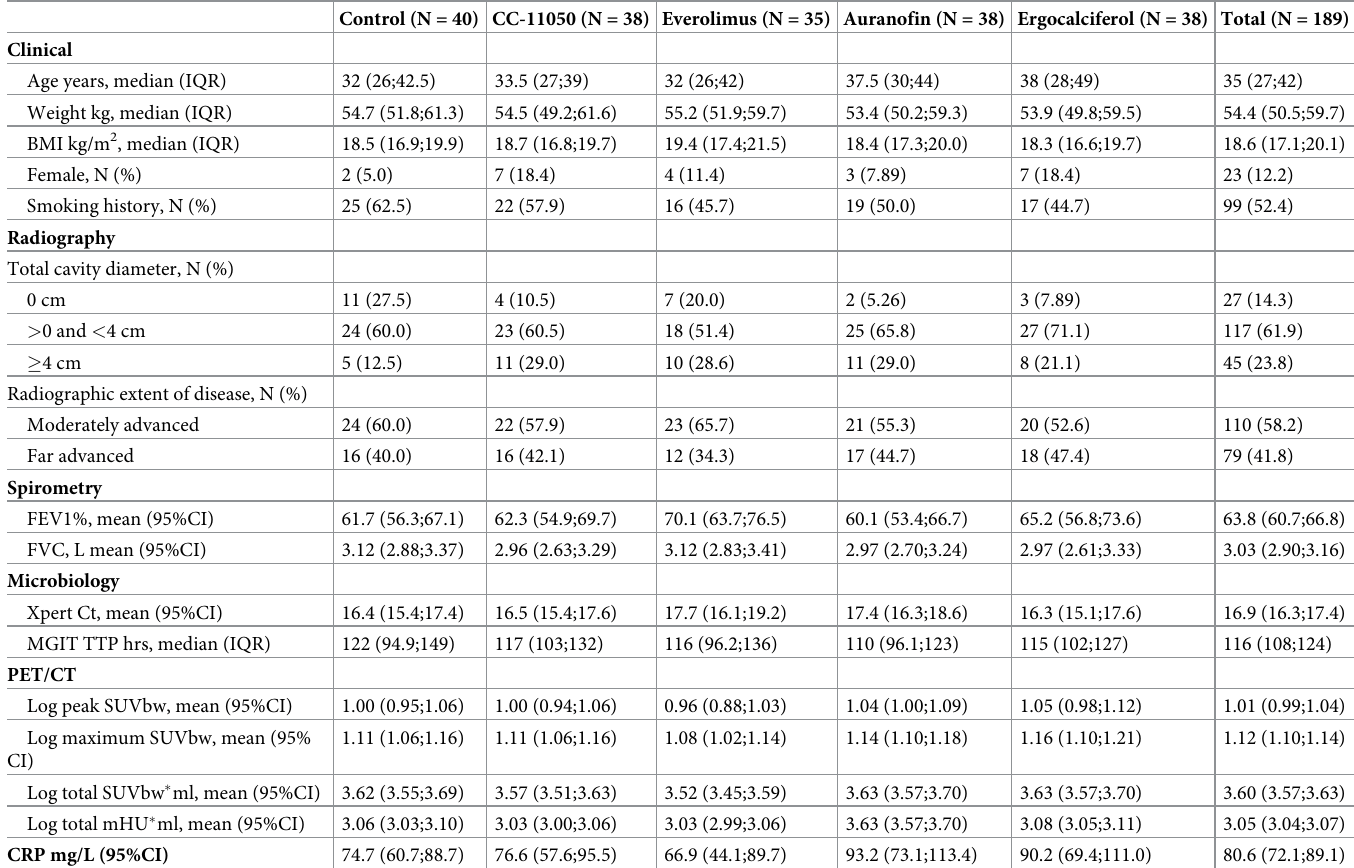
Table 1. Baseline characteristics of the per protocol